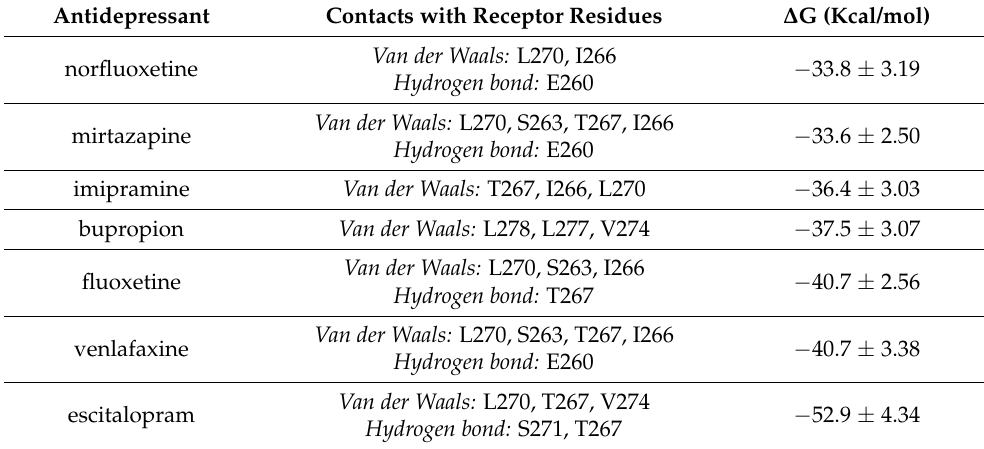
Table 1. Main interactions and binding-free energies of the antidepressants in the α 7 nAChR.